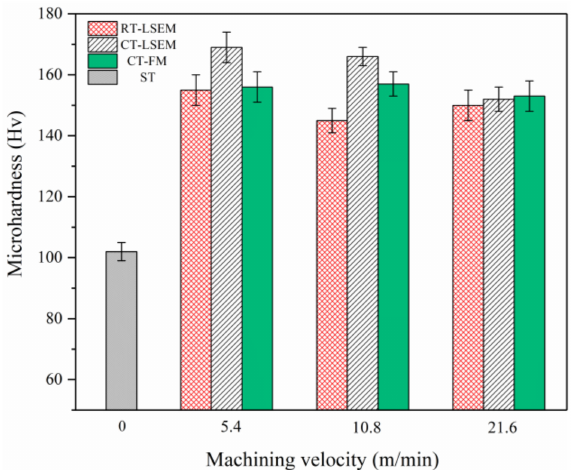
Figure 8. Micro-hardness of ST, RT-LSEM, CT LSEM, and CT-FM samples as a function of machining velocity, the velocity of Vc = 0 m / min represents the ST